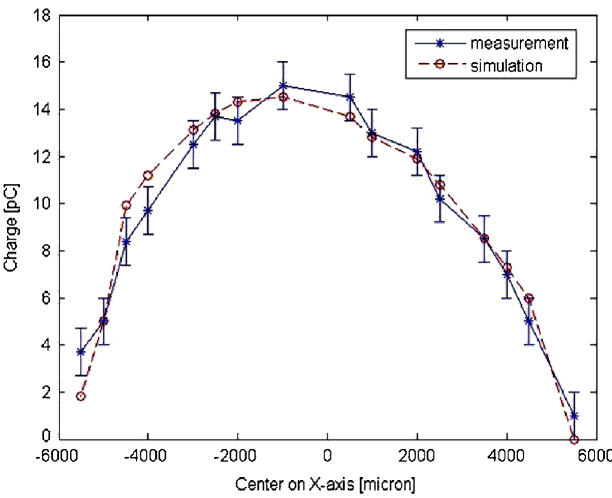
FIG. 12. Charge downstream of BC1 during compression ( C ¼ 6 : 5 ) vs horizontal scraper position. Two blades of the scraper select an open window of 1 mm. The horizontal particle distribution in the middle of BC1 reflects the particle energy